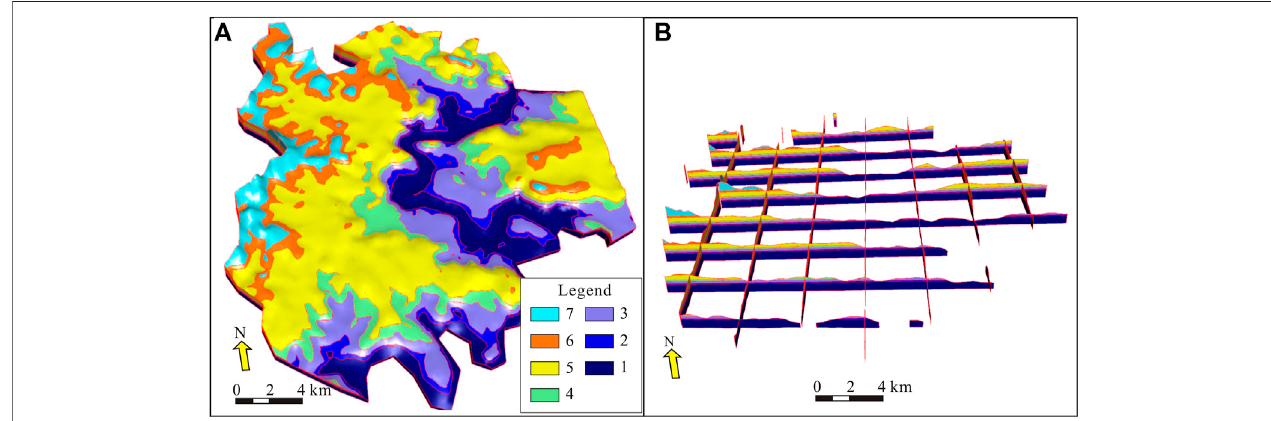
FIGURE 6 | 3D Geological model of Guang ’ an city (A) and fence diagram (B)